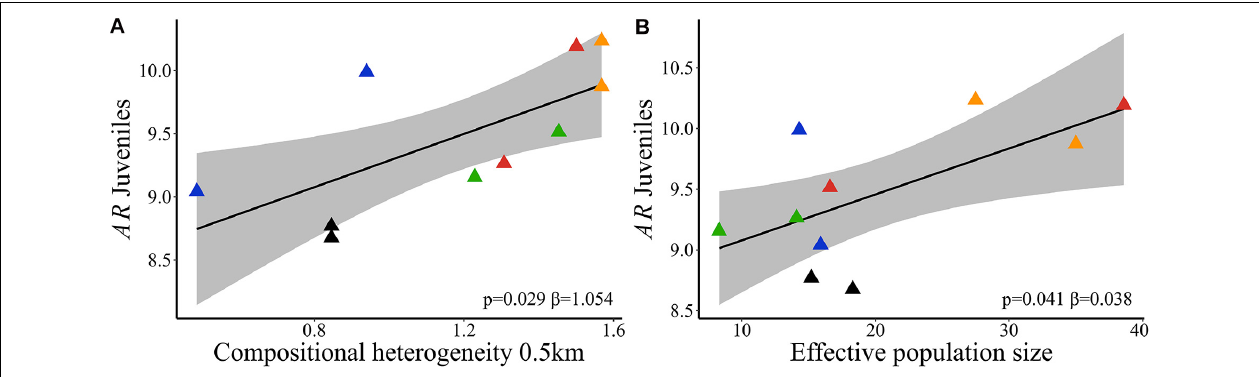
FIGURE 5 | Relationships of neutral genetic variability and landscape compositional heterogeneity (SHDI) in Caryocar brasiliense based on 10 sampling sites in the Cerrado biome, Brazil. (A) Allelic richness ( AR ) in juveniles and SHDI at node level (%). (B) AR in juveniles and effective population size ( Ne ). Black line is the linear regression fit and shaded area is the 95% confidence interval. Triangle color corresponds to the landscape: red = L1; blue = L2; orange = L3; green = L4; black =